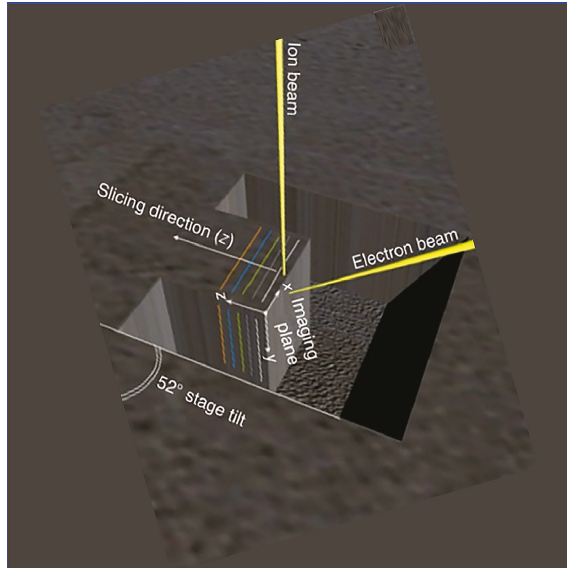
Figure 1: The schematic diagram of the FIB-SEM system